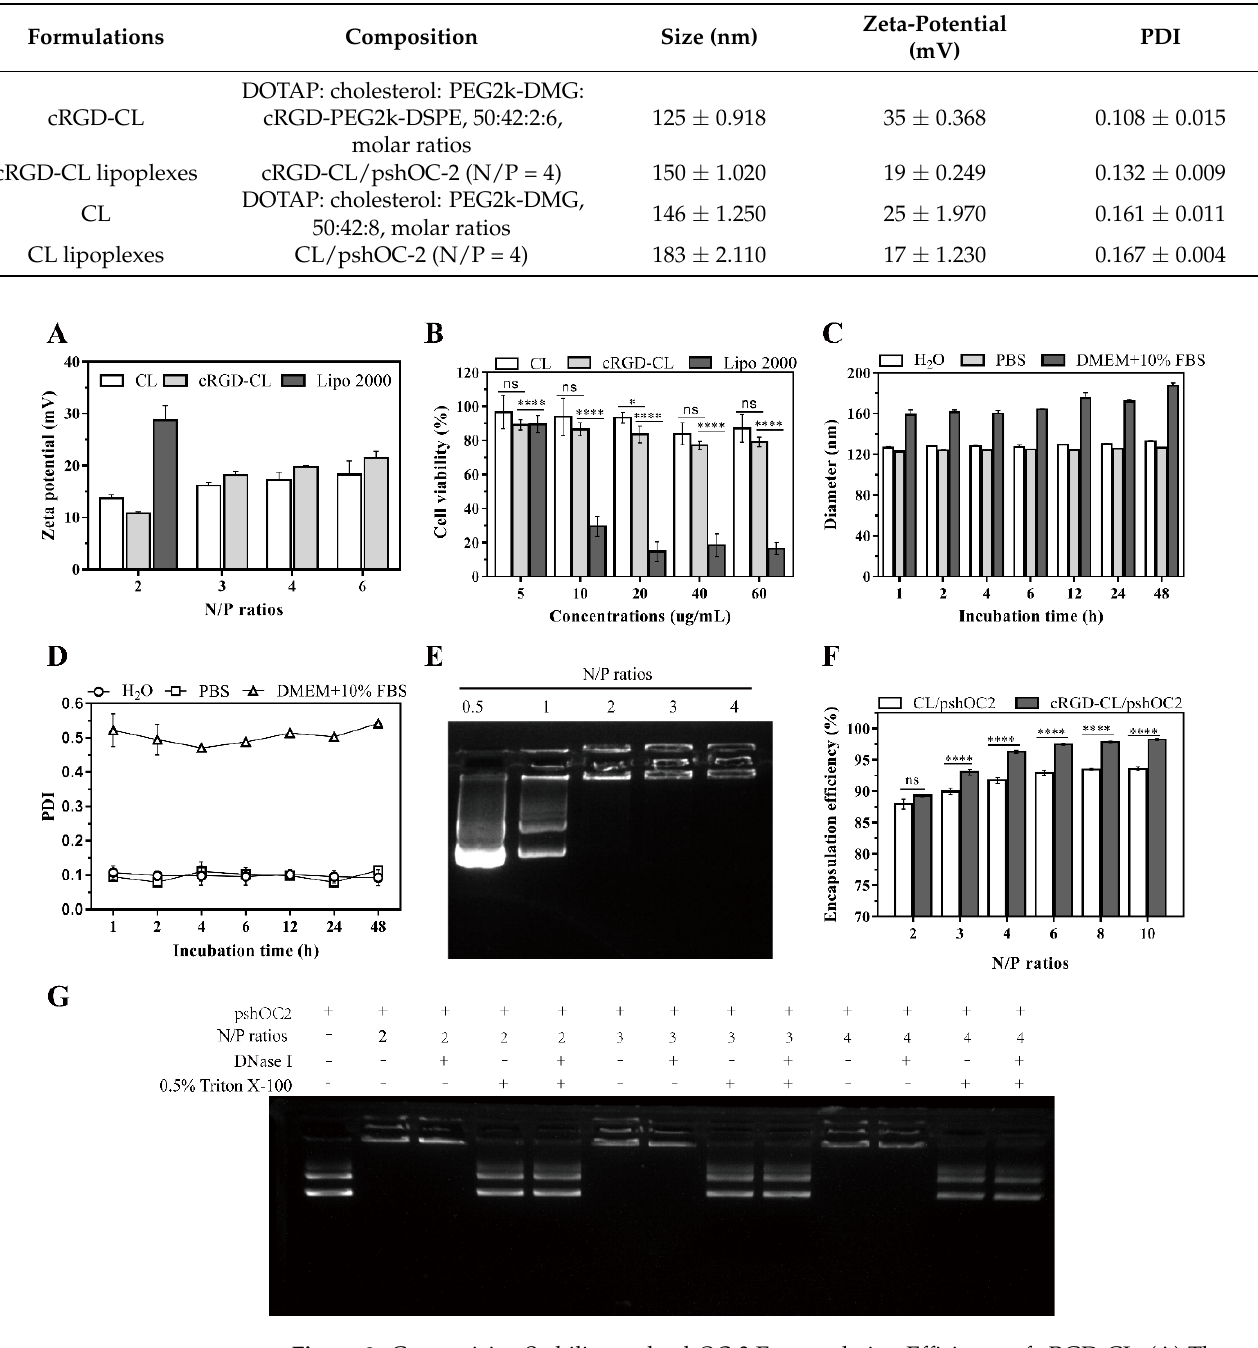
Figure 2. Cytotoxicity, Stability and psh OC-2 Encapsulation Efficiency of cRGD-CL. ( A ) The zeta potential of cRGD-CL lipoplexes at different N/P ratios. ( B ) The cell viability of MCF-7 cells treated with different concentrations of CL, cRGD-CL and Lipo 2000 for 24 h, respectively. The diameter ( C ) and PDI ( D ) of cRGD-CL incubated in H 2 O, PBS and DMEM + 10% FBS within 48 h. ( E ) The 1% agarose retardation assay of cRGD-CL lipoplexes at the N/P ratios of 0.5, 1, 2, 3 and 4. ( F ) The nucleic acid encapsulation efficiency of cRGD-CL and CL with the N/P ratios at 2, 3, 4, 6, 8 and 10. ( G ) The protective effect of cRGD-CL on plasmid DNA under different N/P ratios was determined by DNase I enzymatic hydrolysis assay. Data were presented as mean ± SD, ns: No statistical difference. * p < 0.05, **** p < 0.0001.